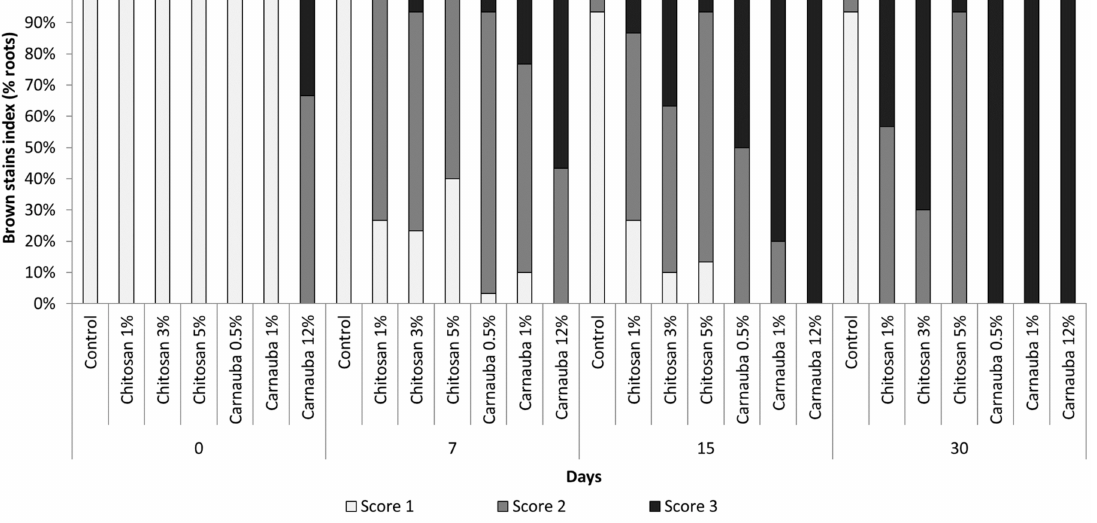
Figure 1. Brown stain index of yellow carrots treated with different edible coatings and stored at 2 ◦ C 95–100% RH. Score: 1 = roots without stains; 2 = roots with light or few stains; 3 = roots with a large amount of stains or with darker